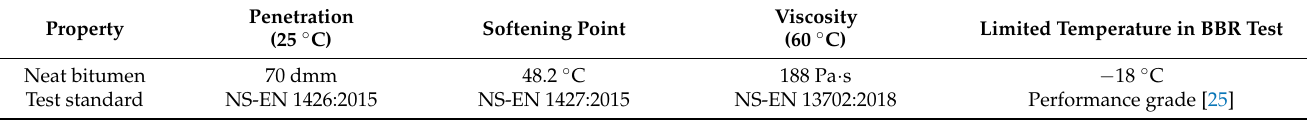
Table 1. Basic properties of neat